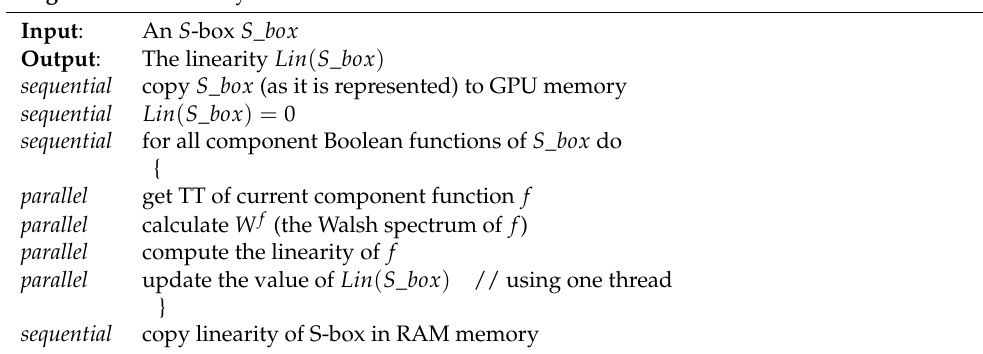
Algorithm 1 : Linearity of an S -box.